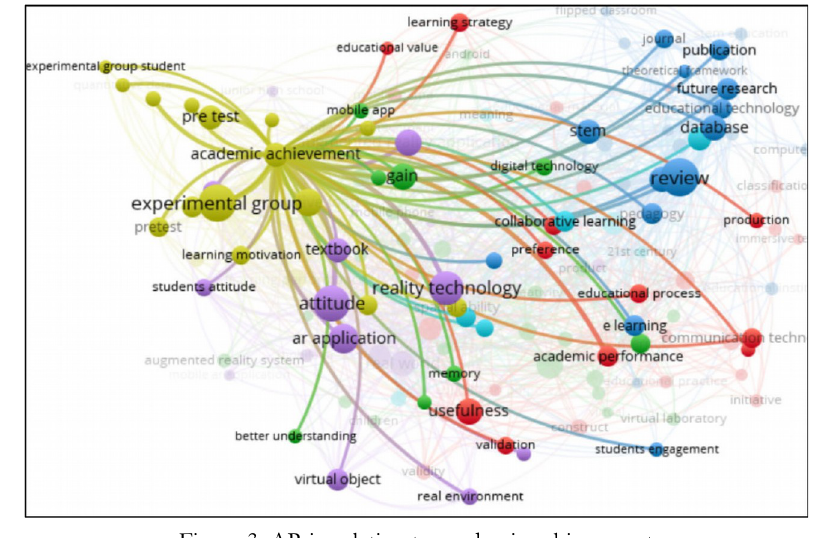
Figure 3. AR in relating to academic achievement